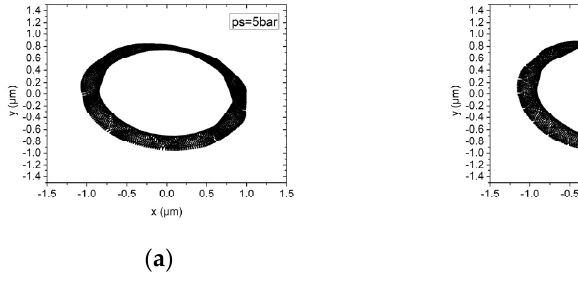
Figure 17. Rotor center trajectory under different supply pressure under working condition 5 (high speed, dynamic unbalance G1). ( a ) Rotor center trajectory ( ps = 5 bar), ( b ) rotor center trajectory ( ps = 6 bar), ( c ) rotor center trajectory ( ps = 7 bar).